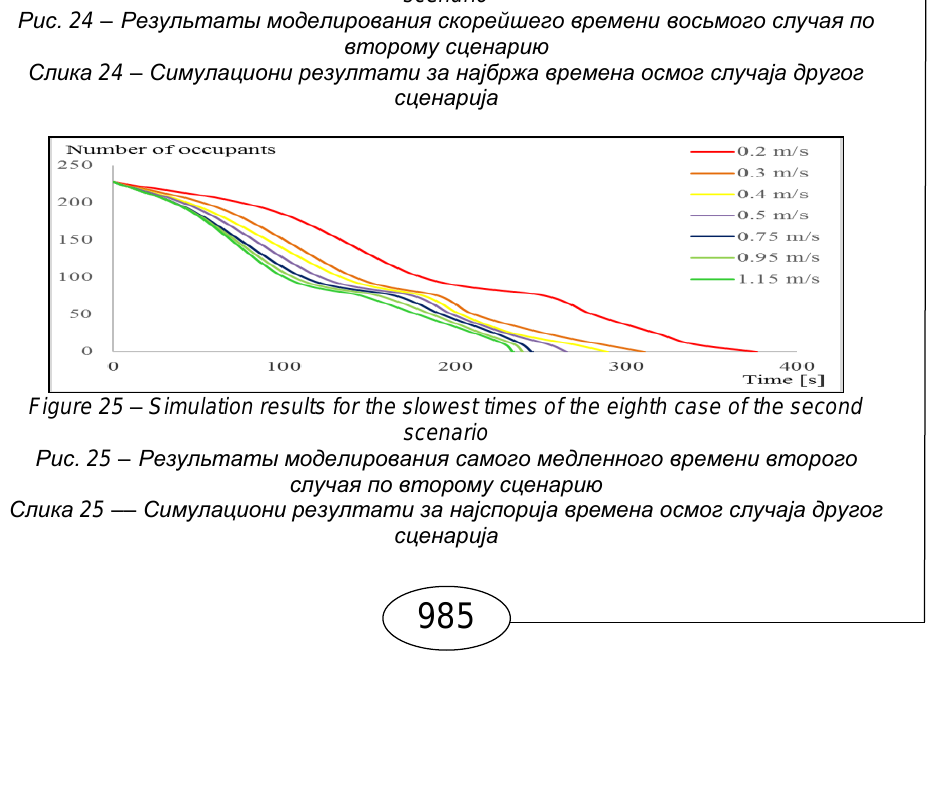
Figure 24 – Simulation results for the fastest times of the eighth case of the second scenario